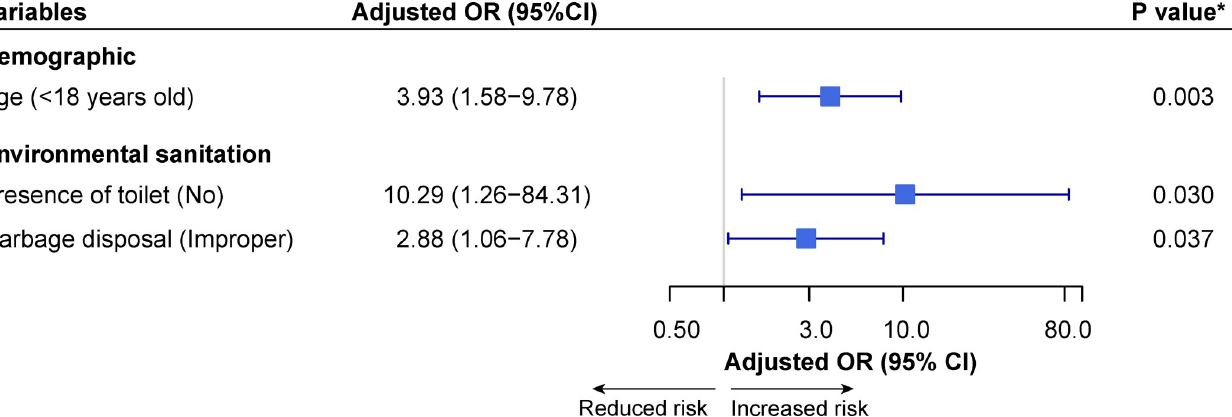
Fig 2. Forest plot of multivariate analysis of potential risk factor associated with STH infections among the study population. Adjusted OR = Adjusted Odds ratio; CI = Confidence interval; � = Significant risk factors ( P < 0.05).